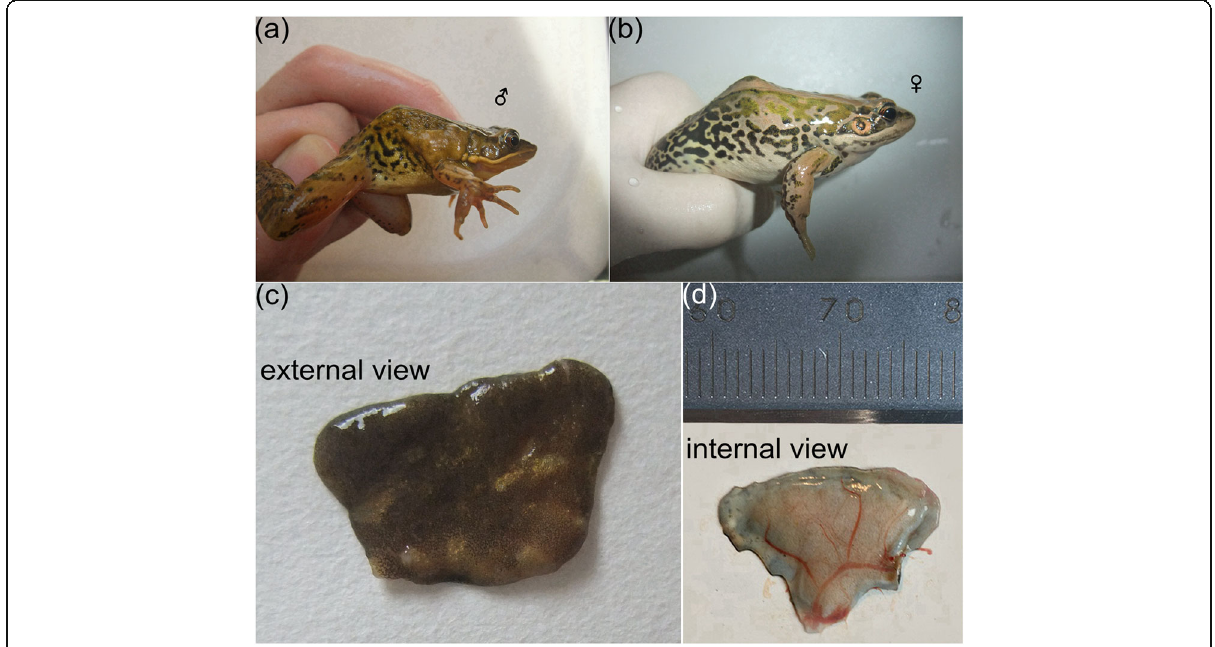
Fig. 1 Macroscopic view of the postaxillary gland in N. pleuraden . a Lateral view of a male N. pleuraden . b Lateral view of a female N. pleuraden , note the absence of postaxillary gland. c A freshly dissected postaxillary gland. d The inner side of a freshly dissected postaxillary